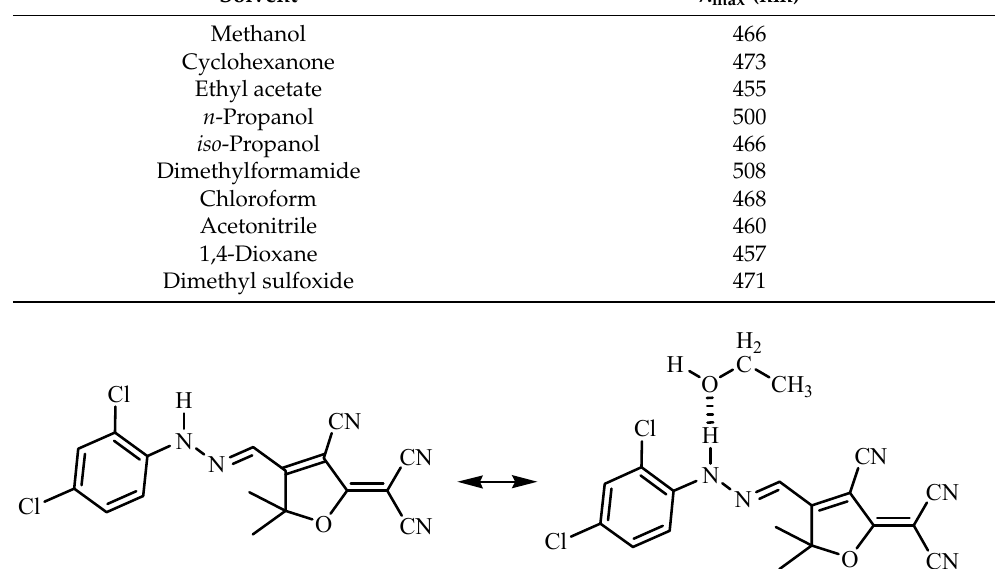
Figure 1. Absorption spectra of the hydrazone chemosensor in a range of different solvents. Table 1. Maximum absorbance wavelength of the hydrazone chemosensor in various solvents.